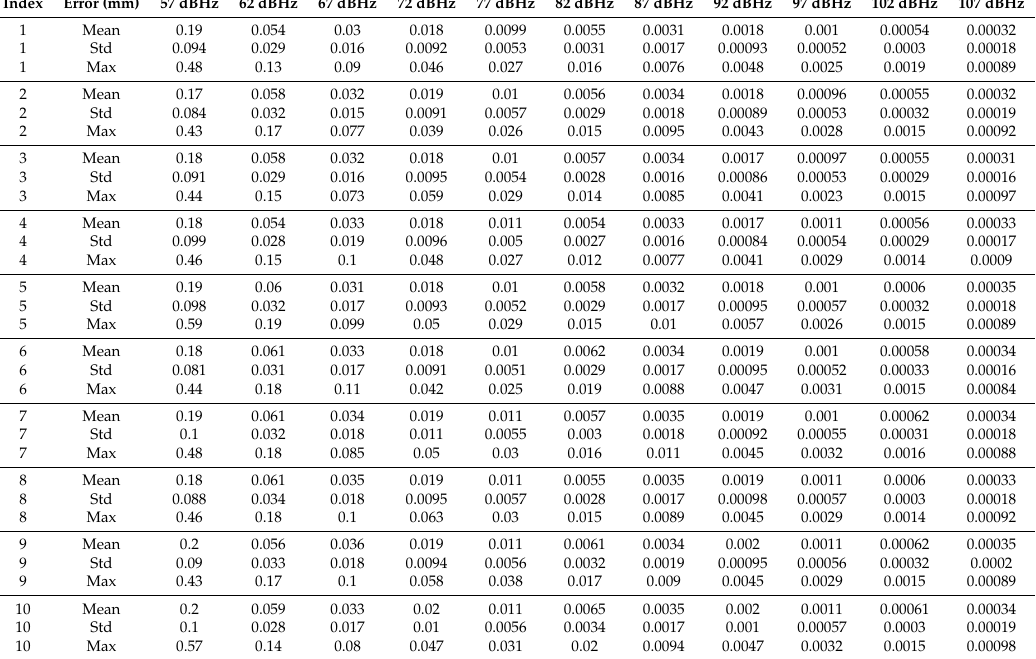
Table A2. Mean values, standard deviation, and maximum error values in the calculation of the impact point using CDMA-BPSK with a 8-bit